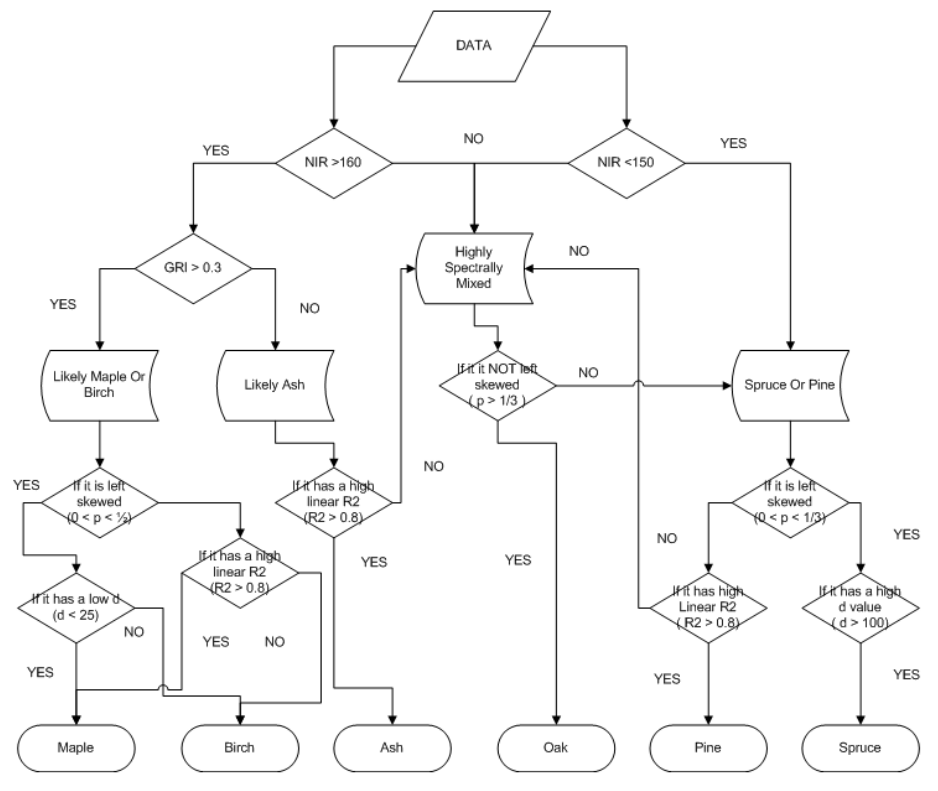
Figure 8. The knowledge-based decision tree